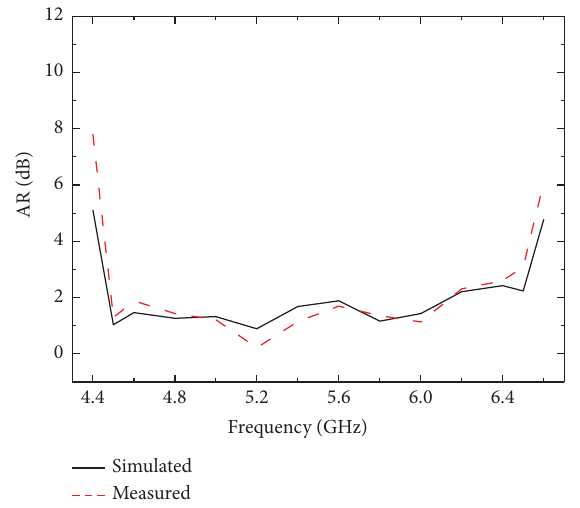
Figure 18: Comparison of simulation and measurement of axial ratio.